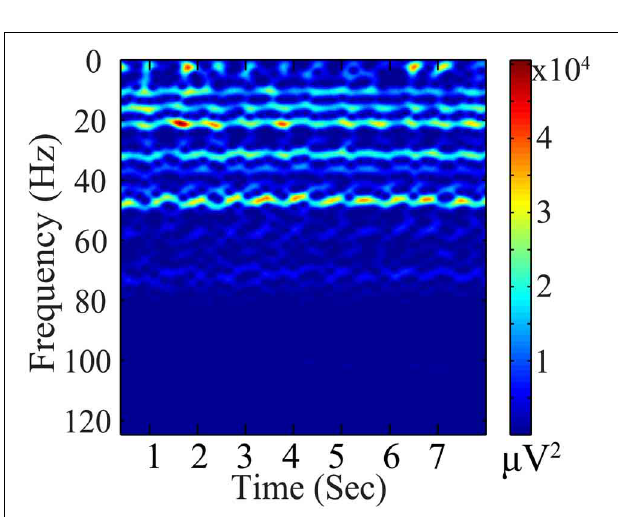
FIGURE 4 | Spectrogram ( μ V 2 ) of BCG artifacts (from one